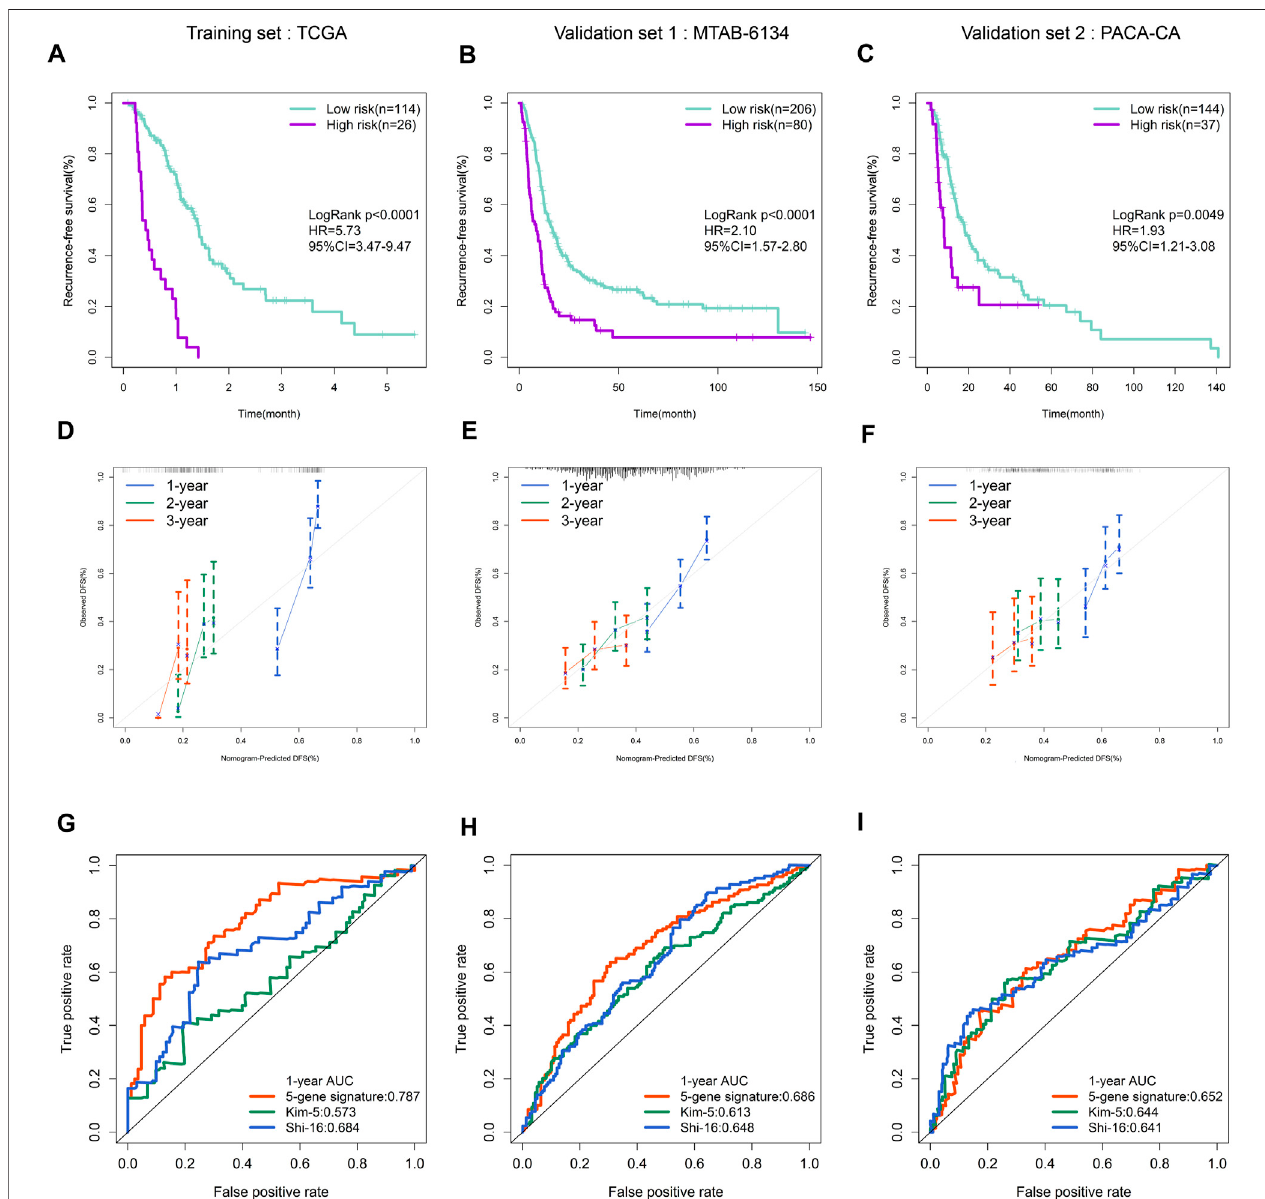
FIGURE 3 | Prognostic validation of the ferroptosis-related gene signature. (A – C) K – M curves evaluating the RFS between low- and high-risk groups in three independent cohorts. (D – F) Calibration curves for risk score in three independent cohorts. (G – I) ROC curves of risk models in three independent cohorts.